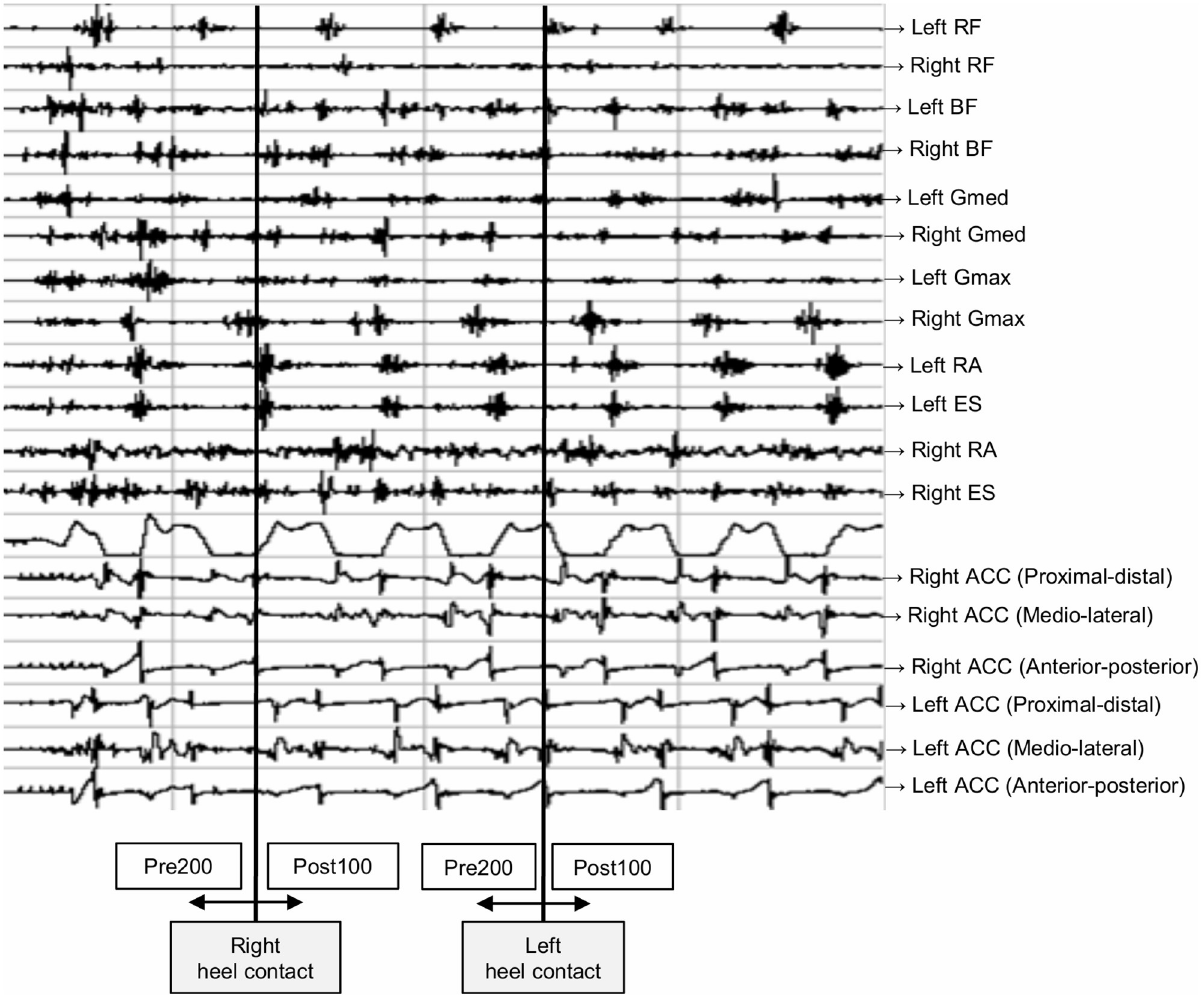
Fig 2. Visualized signals for each recorded muscle and the acceleration sensors in the electromyography analysis software during an unperturbed waling trial. Heel contacts provoked visible spikes, which assisted the data analyzer in detecting the heel contacts. Pre200: 200 to 0 ms before initial heel contact. Post100: 0 to 100 ms after initial heel contact. RF: rectus femoris, BF: biceps femoris, Gmed: gluteus medius, Gmax: gluteus maximus, RA: rectus abdominus, ES: erector spinae. ACC: the acceleration sensors.